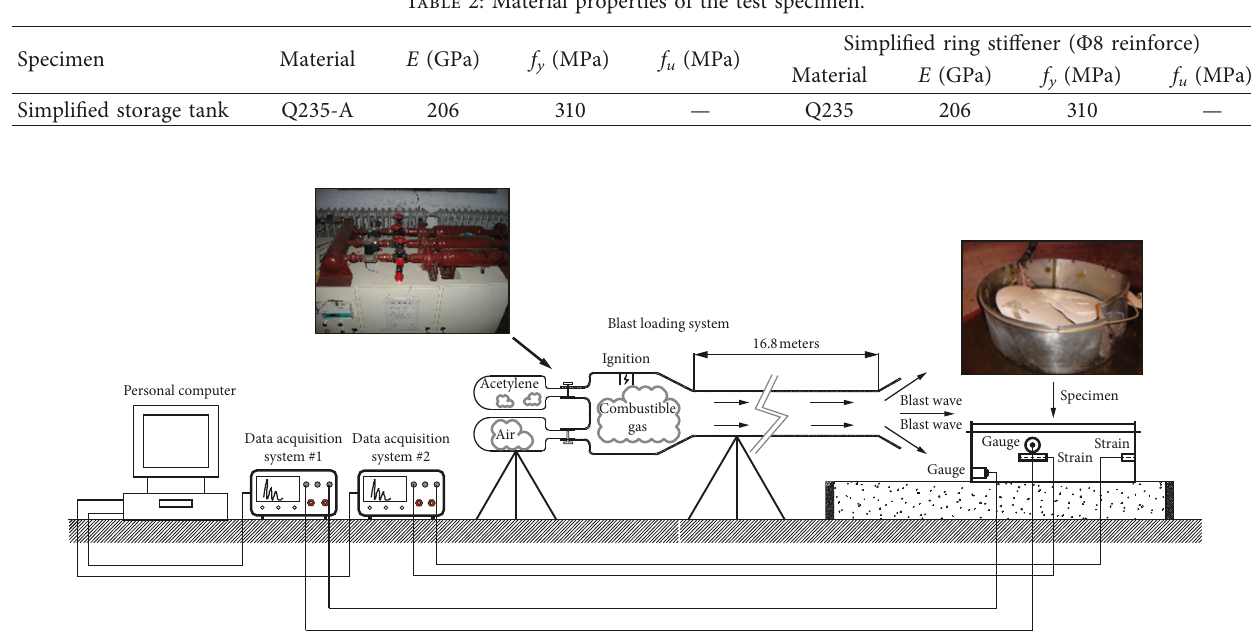
Figure 2: Schematic diagram of test setup.